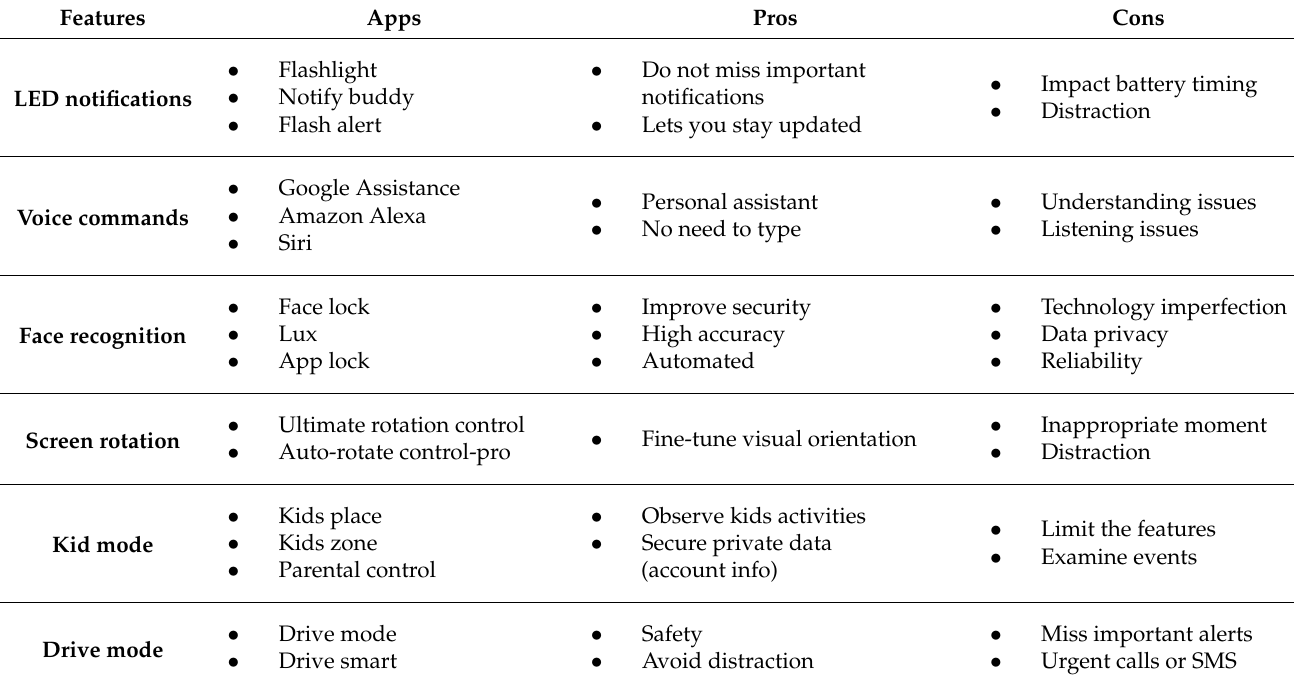
Table 1. Pros and Cons of selected